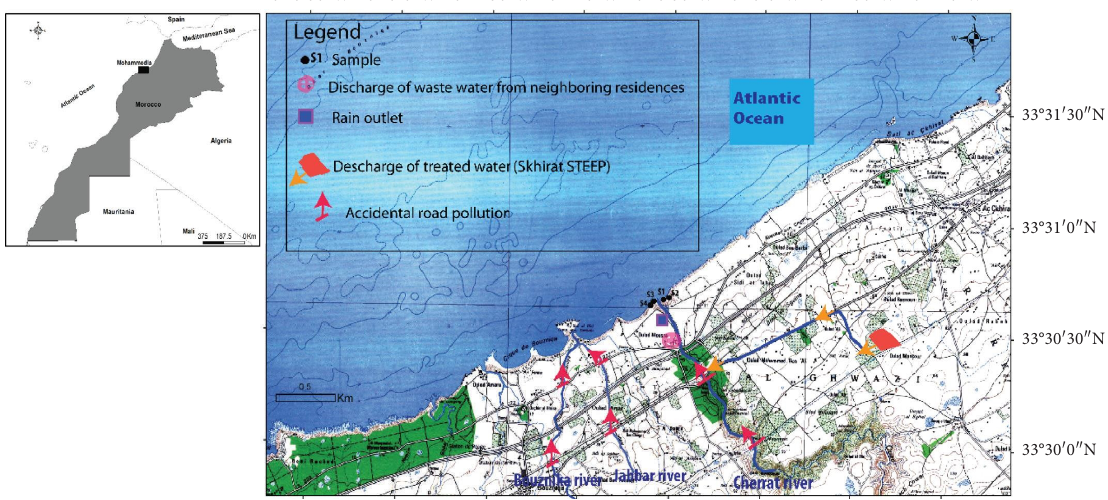
Figure 1: Mussel sampling areas at Cherrat